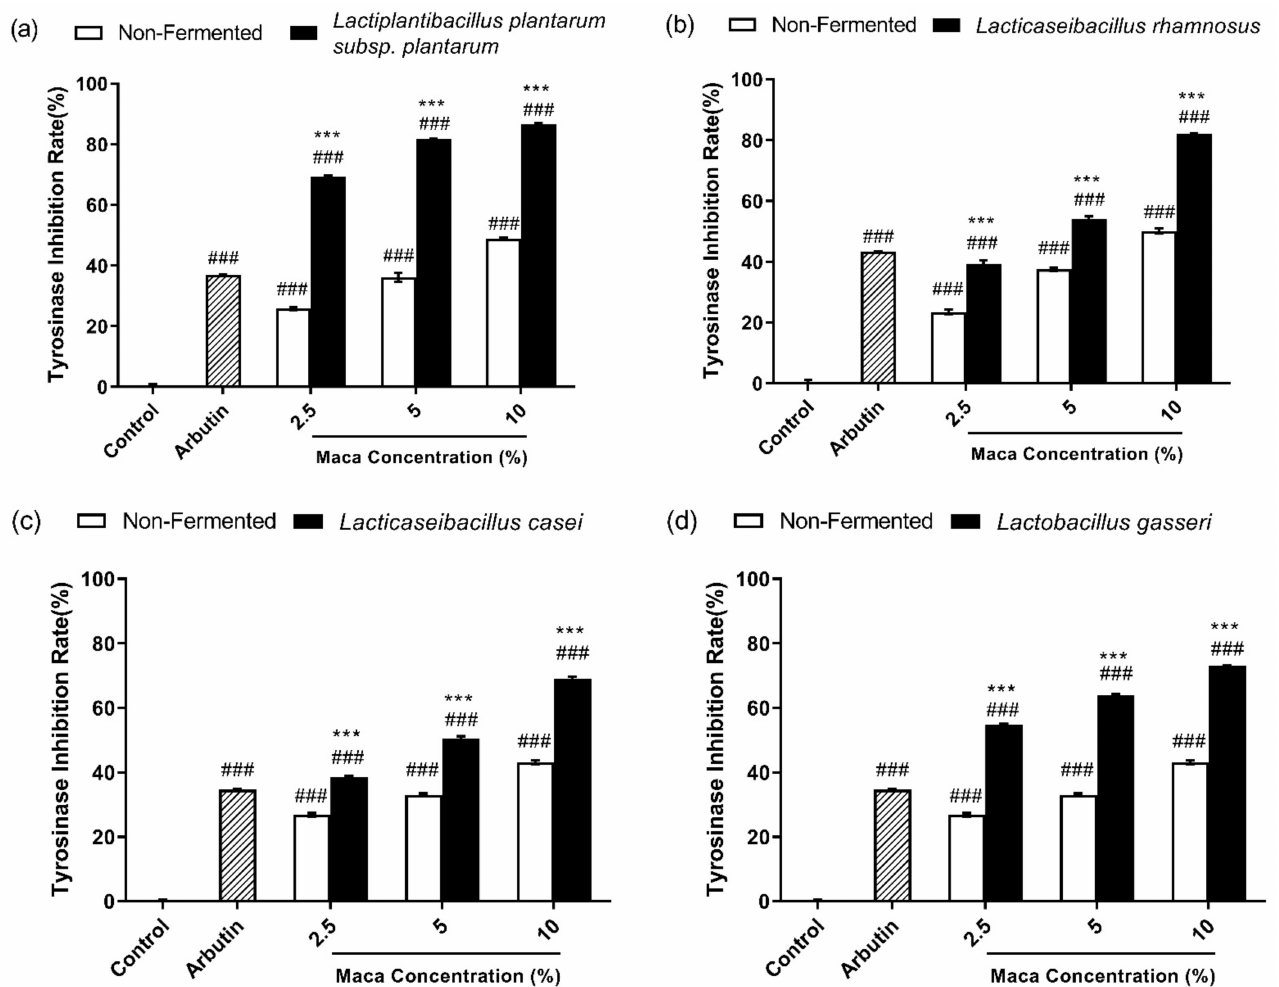
Figure 5. Effects of non-fermented and fermented maca root extracts on the inhibition rate (%) of mushroom tyrosinase. Treated with maca root extracts fermented using ( a ) Lactiplantibacillus plantarum subsp. plantarum KCTC 3108, ( b ) Lacticaseibacillus rhamnosus KCTC 5033, ( c ) Lacticaseibacillus casei KCTC 3109, and ( d ) Lactobacillus gasseri KCTC 3143. Error bars, mean ± SD. ### p < 0.0005 compared to the control group, and *** p < 0.0005 compared to the same concentration of non-fermented maca root